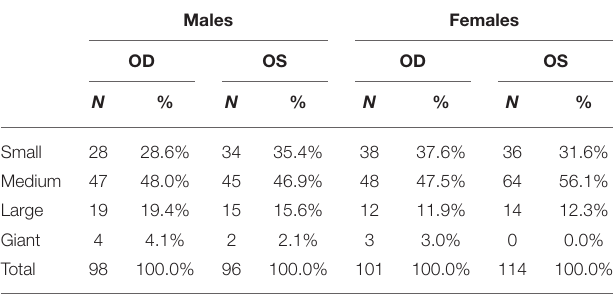
TABLE 2 | The morphology of the